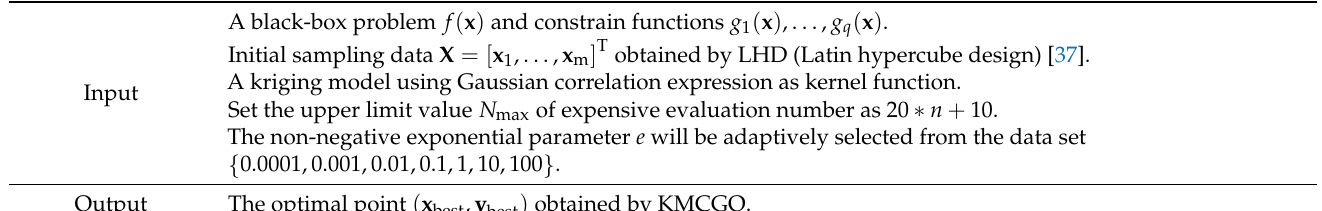
Table 1. Input and output parameters of the KMCGO